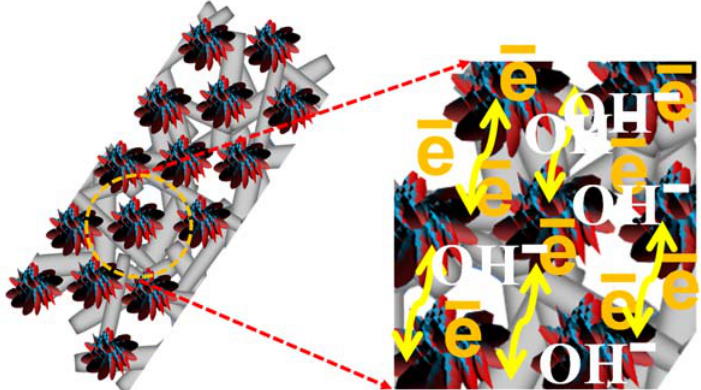
Figure 6. Expected mechanism for interaction and charge over electrodes and electrolytes during electrochemical analysis.